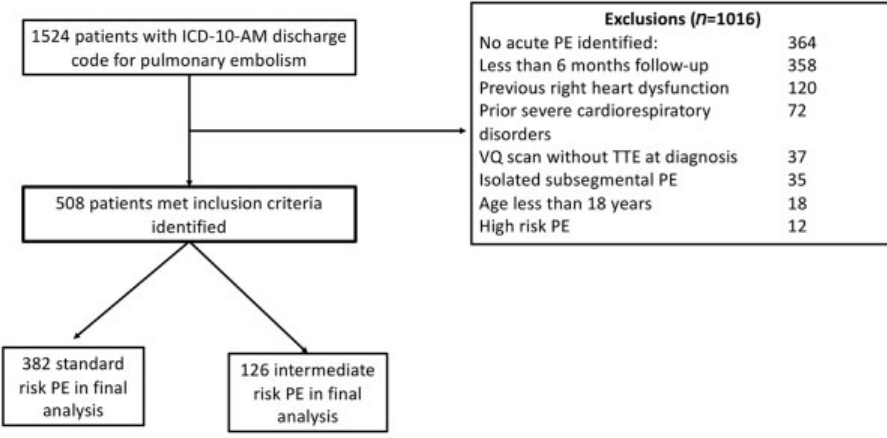
Fig. 1 Flowchart for inclusion and exclusion